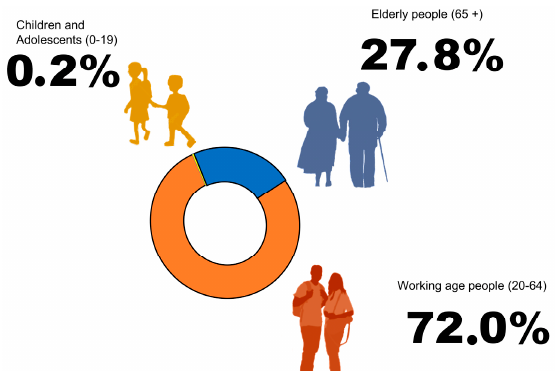
Figure 1. Diabetes mellitus is a global problem. A. The estimated number of people aged over 65 y with DM was 111 million in 2019. (1:5 people of this age are predicted to have DM). It is projected that by 2045, the number of people aged over 65 y with DM will reach 276 million. B. An estimated 1.1 million children and adolescents (aged under 20 y) have type 1 DM. Overweight and obesity are increasing the number of children and adolescents with type 2 DM. C. Three in four people living with DM are working age (aged 20–64 y), and this number is expected to increase to 486 million by 2045. IDF, Atlas of Diabetes 2019 [49].